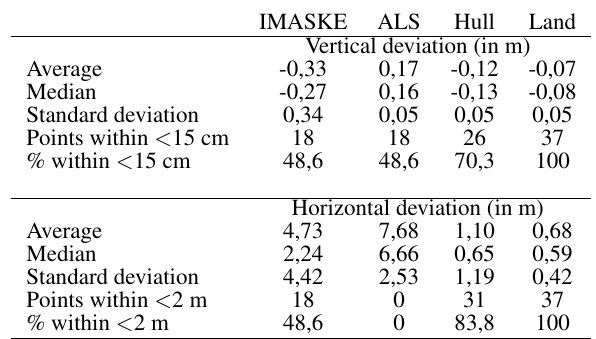
Figure 7. Vertical and horizontal deviations of WLBs to GNSS reference points. Tolerance lines are indicated.